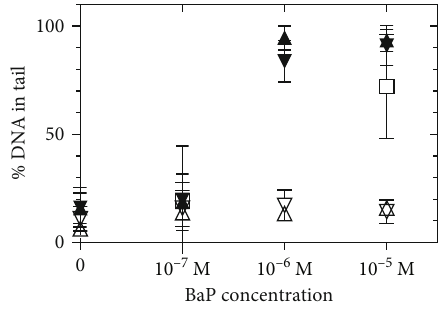
Figure 2: Comet assay results plotted as percentage DNA in the tail. M: mol/L. Open triangles: control no UV exposure. Filled triangles: UVA exposure of 30 min at an intensity of 3.5mW/cm 2 (6.3 J/cm 2 ). Data from 2 separate replicate experiments is included. Open squares: UVA 10 min exposure (2.1 J/cm 2 ). M: mol/L. Results were calculated and plotted as the mean and standard deviation (see Materials and